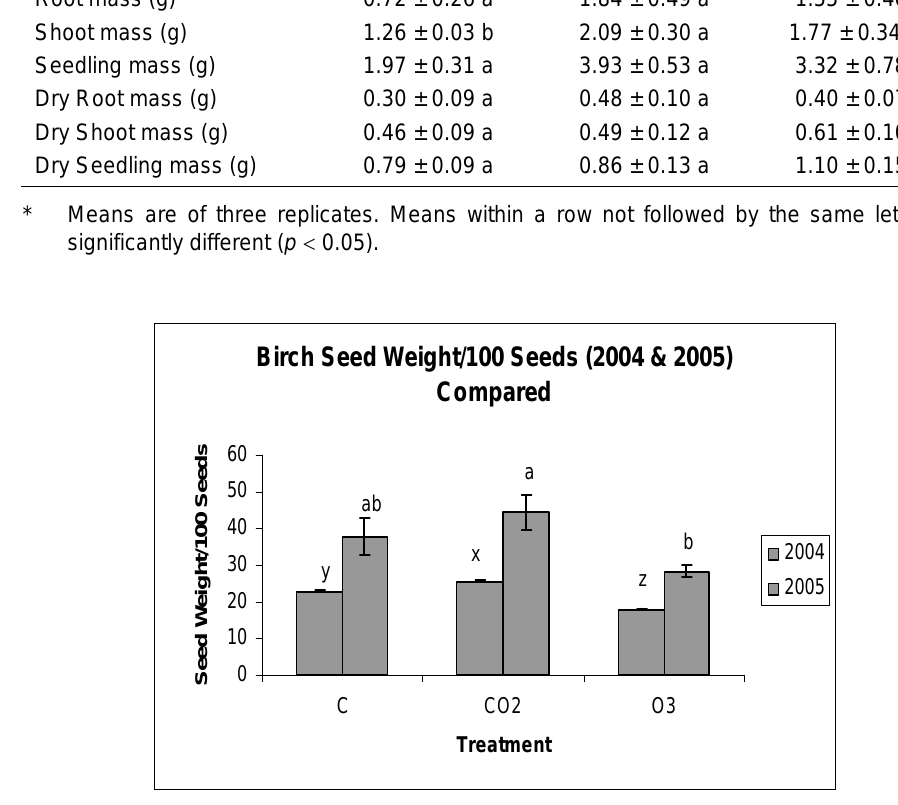
FIGURE 1. Weight per 100 seeds of birch collected from 2004 and 2005 growing seasons. The letters a, ab, and b; x, y, and z show significant differences between treatments in 2004 and 2005 growing seasons, respectively, at 0.05 significance level.